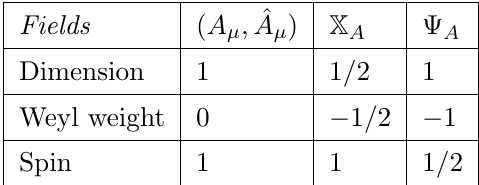
Table 1 . Basic (cid:12)elds and their